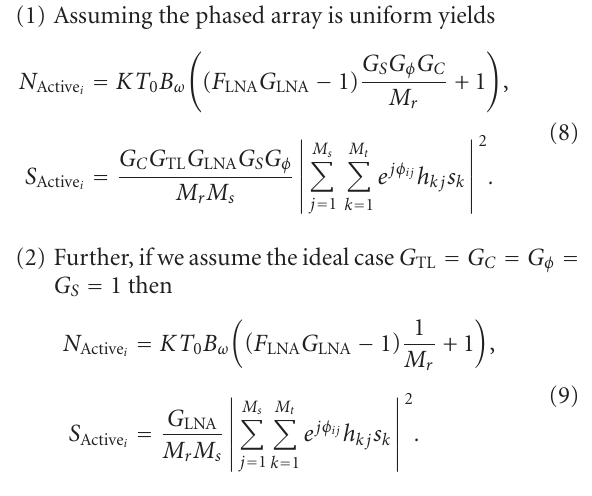
noise on each input branch is uncorrelated to the others [10, page